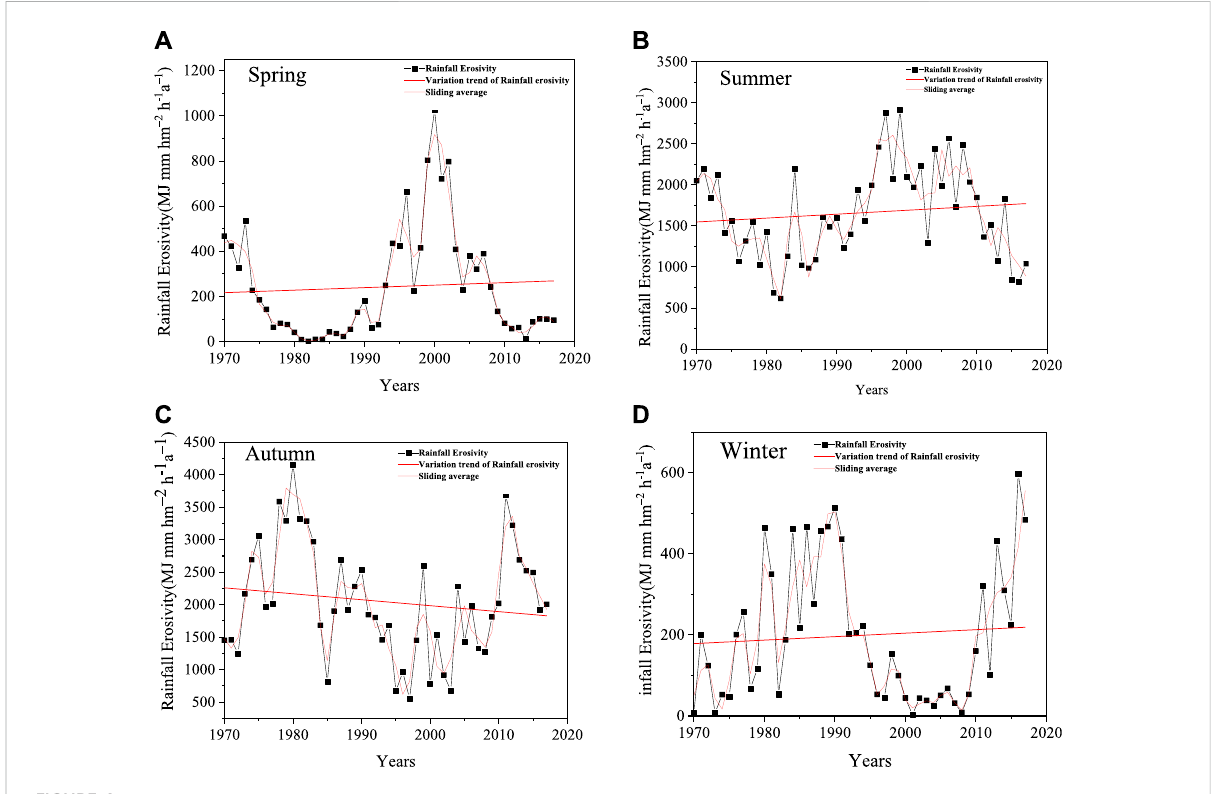
FIGURE 4 Variation trend of Spring (A) , Summer (B) , Autumn (C) and Winter (D) in Qinba